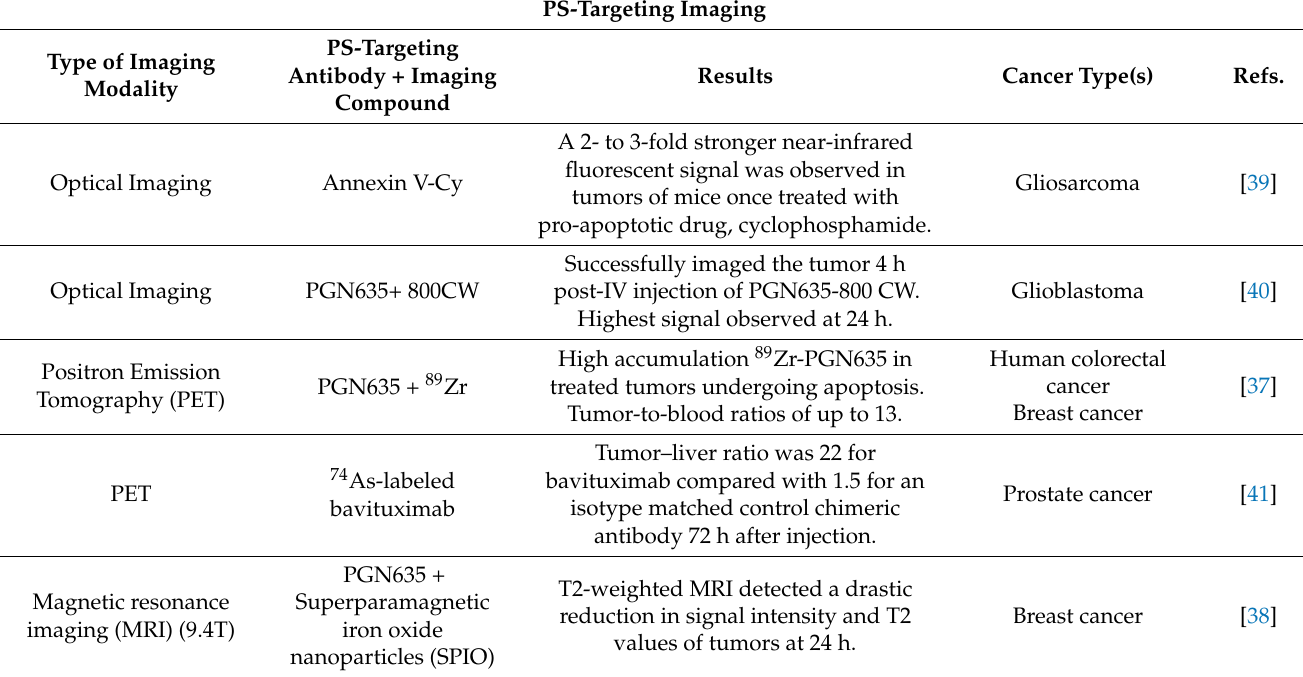
Table 1. Phosphatidylserine (PS)-targeting imaging